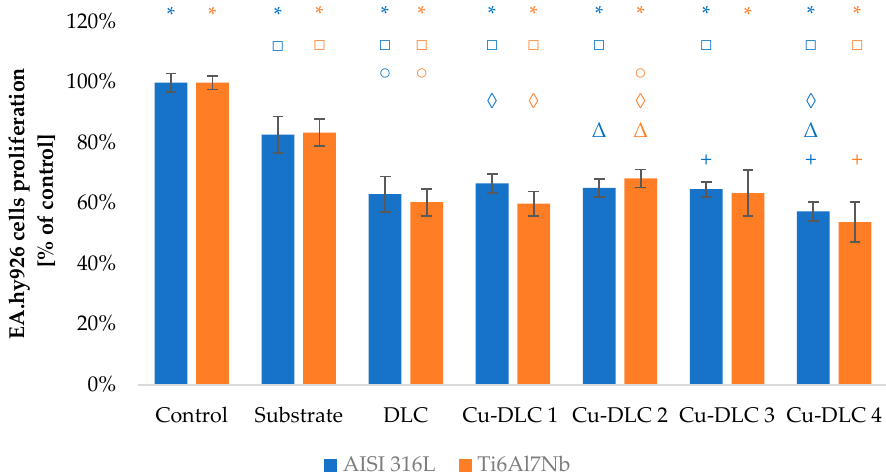
Figure 11. Assessment of proliferation of EA.hy926 cells in contact with Ag-DLC coatings. Results of XTT test examination.